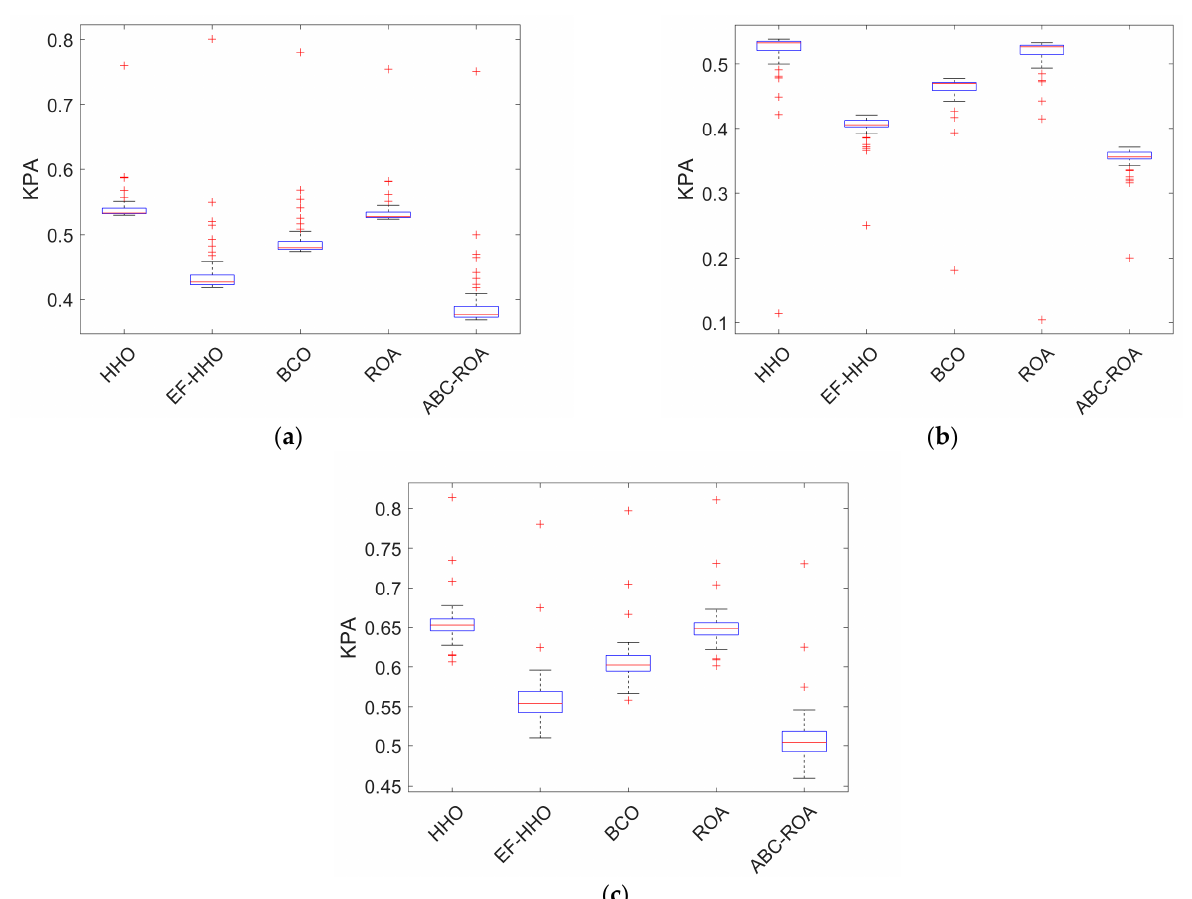
Figure 13. Performance analysis of the developed ABC-ROA based privacy preservation model using KPA regarding ( a ) dataset 1, ( b ) dataset 2, and ( c ) dataset 3.